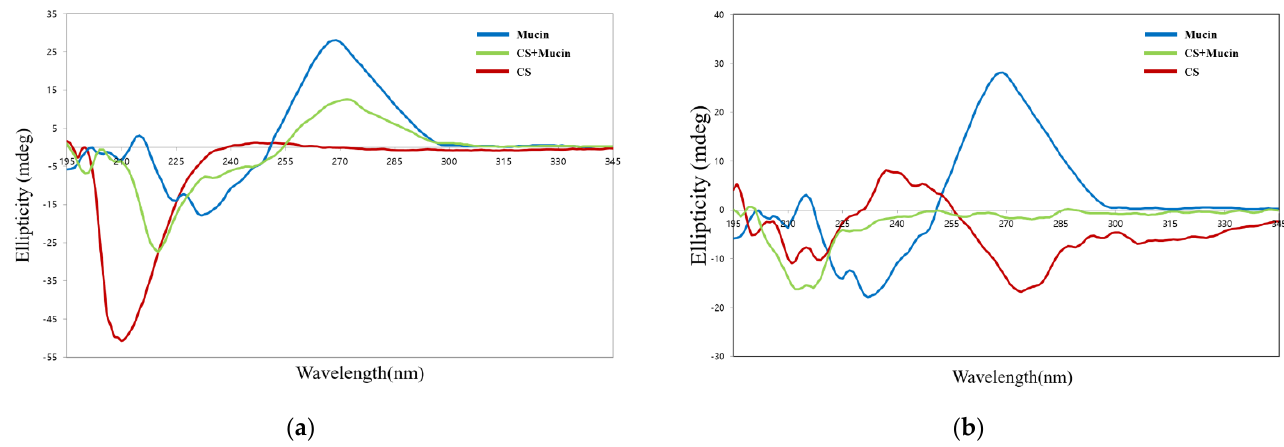
Figure 5. Circular dichroism spectra of CS, mucin, and CS + mucin ( a ) and OCS, mucin, and OCS + mucin ( b ).